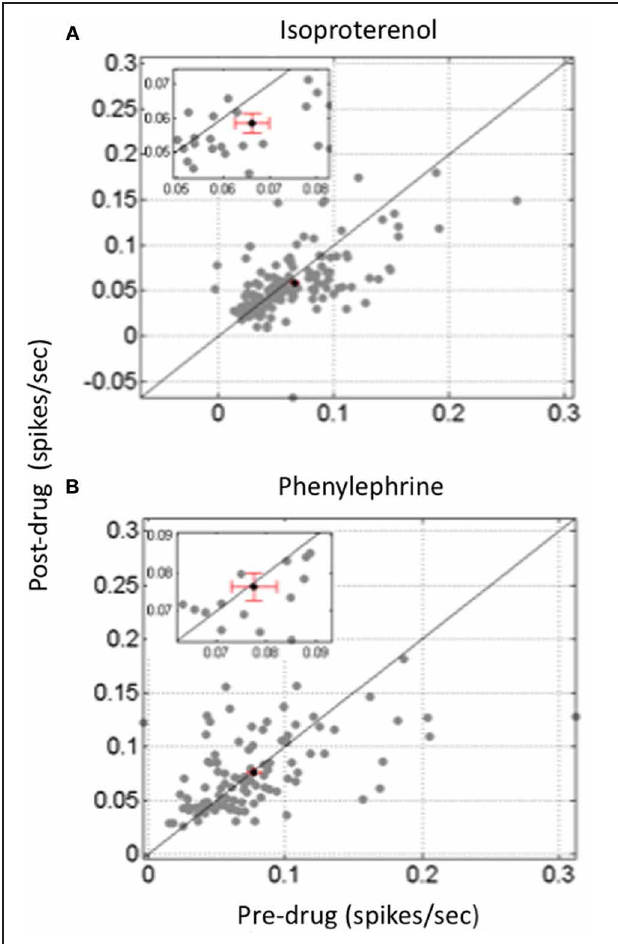
FIGURE 4 | Differential effect of beta and alpha1 agonist on between cells cross-correlations in the auditory cortex. Scattergrams representing the value of the mean cross-correlation obtained pre-drug application against the value obtained after drug application. Data are based on simultaneous recordings collected in less than 400 μ m apart in layer III or IV of the guinea pig auditory cortex. (A) Isoproterenol, a classical Beta agonist, increased evoked activity but significantly decreased the value of between cell cross-correlations. (B) In contrast, Phenylephrine, a classical Alpha1 agonist, decreased evoked activity but had not significant effect on the value of between cell